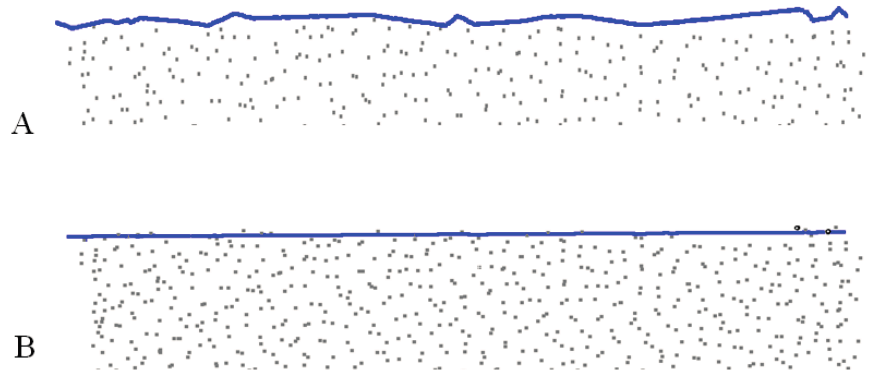
Figure 11. Results of completing edge points: ( A ) Method 1; ( B ) Method 2.